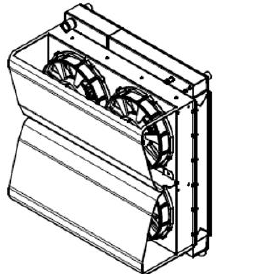
Fig. 13. Selected radiator geometry